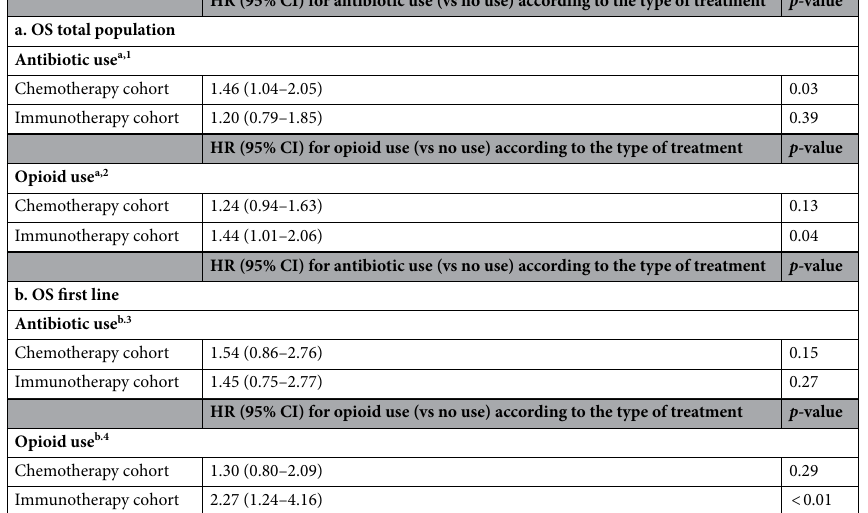
Table 4. Multivariable model for OS within the total population (a) and the 1L (b) for both antibiotic and opioid exposure according to type of treatment (chemotherapy or immunotherapy). The multivariable model includes the variables: a Treatment (immunotherapy vs chemotherapy), histology (squamous vs n on-squamous), line of treatment (≥ 2 vs. 1), antibiotic (use vs no us e) , opioids (use vs no use). 1 Interaction between antibiotic use and type of treatment. 2 Interaction between opioid use and type of treatment. b Treatment (immunotherapy vs chemotherapy), brain metastases (yes vs no), antibiotic (use vs no use),opioids (use vs no use). 3 Interaction between antibiotic use and type of treatment. 4 Interaction between opioid use and type of